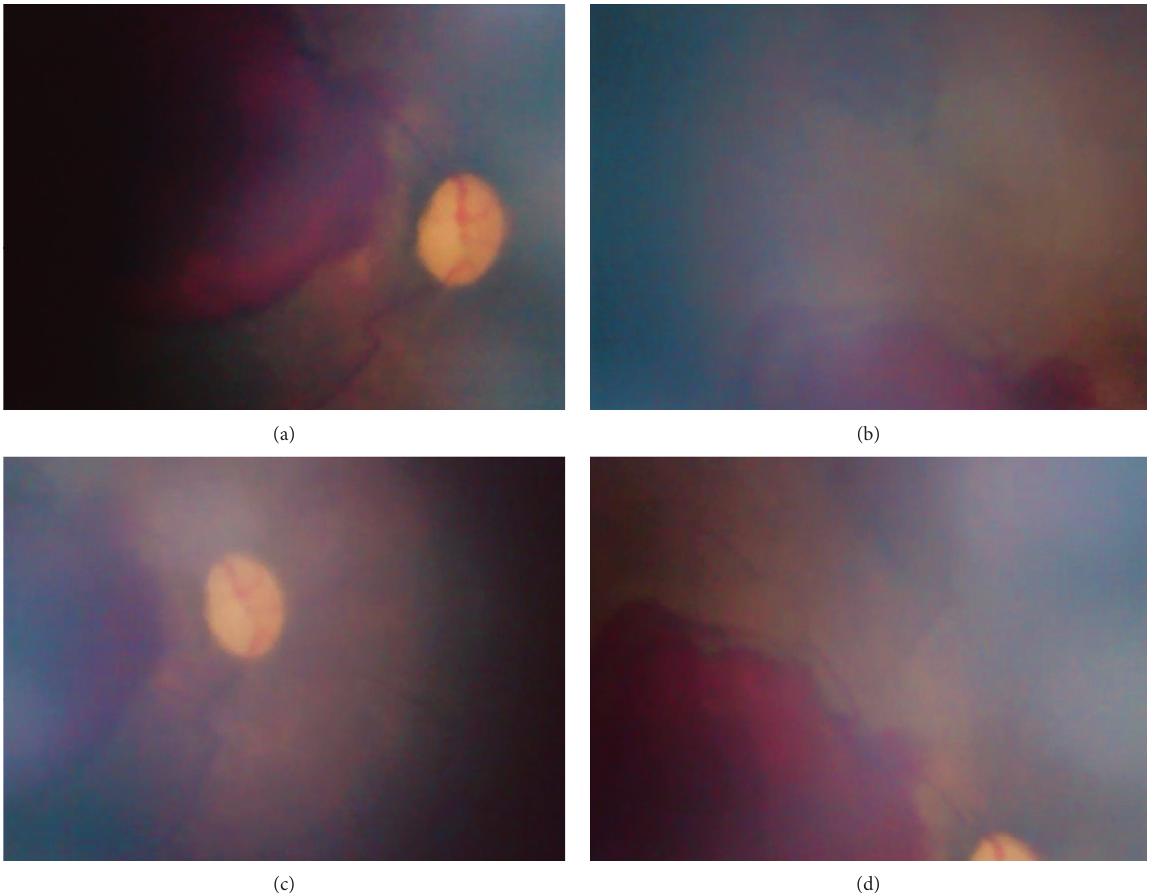
Figure 3: ABCD photographs of the same premature patient with 33.5 weeks of gestation taken with a portable endoscope camera, “Visual Ear Wax Cleaner Tool.”